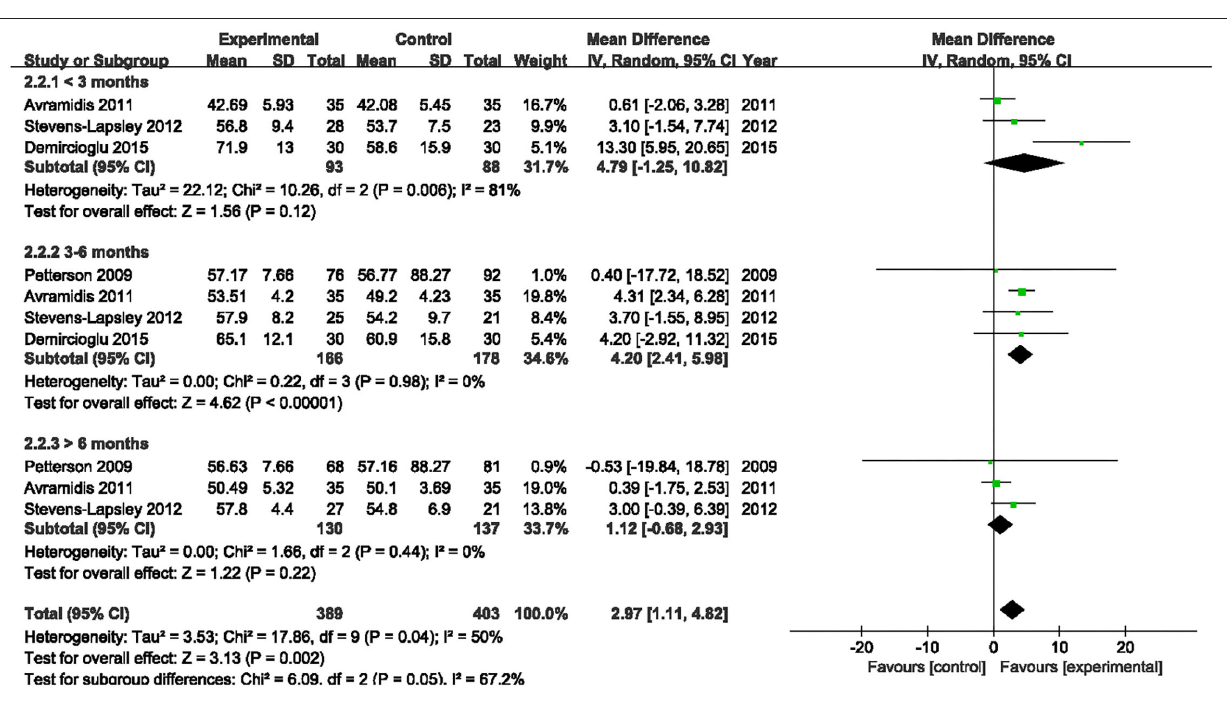
FIGURE 15 | Forest plots of meta-analysis of the effect of NMES vs. conventional rehabilitation on SF-36